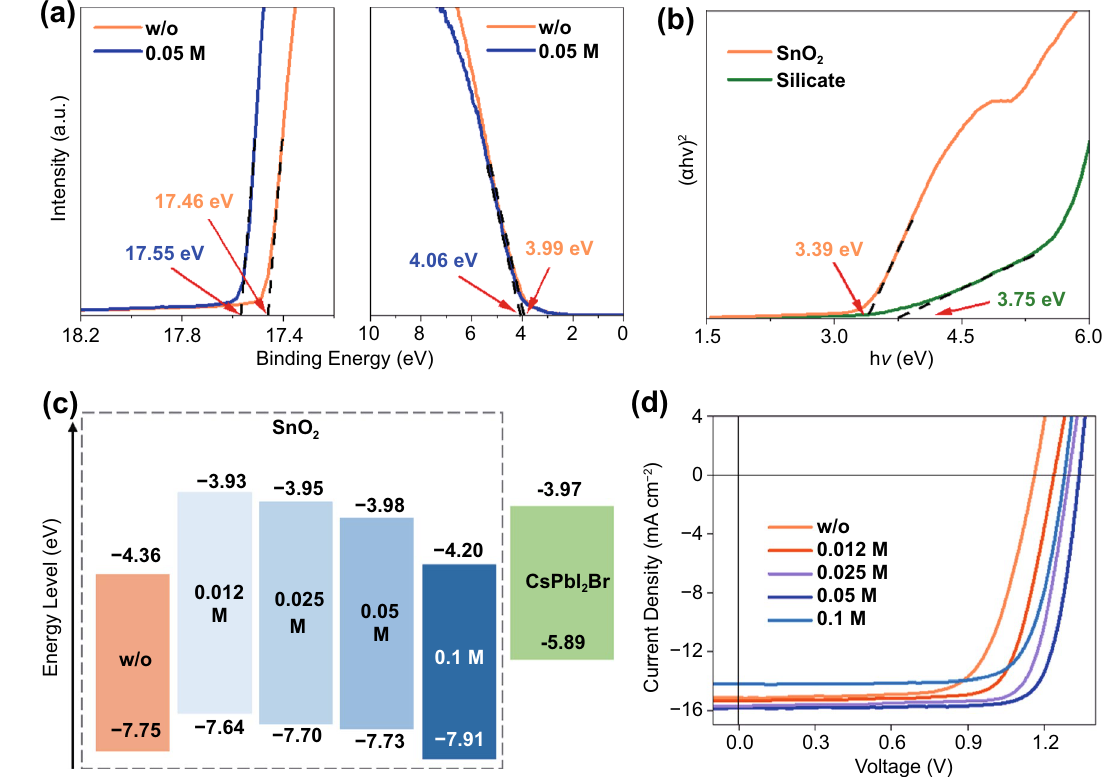
Fig. 4 a Photoemission cutoff spectra (left panel) and valence band (VB) structure (right panel) of SnO 2 films without and with silicate. The dotted lines indicate the secondary electron cutoff position and the valance band onset of the films obtained by linear extrapolating the binding energy edge to the baseline. b Tauc plots of the pure SnO 2 and silicate powders. c Energy level scheme of the charge transport and perovskite layers in this work. d J–V curves of typical CsPbI 2 Br solar cells with different concentrations of silicate anions in SnO 2